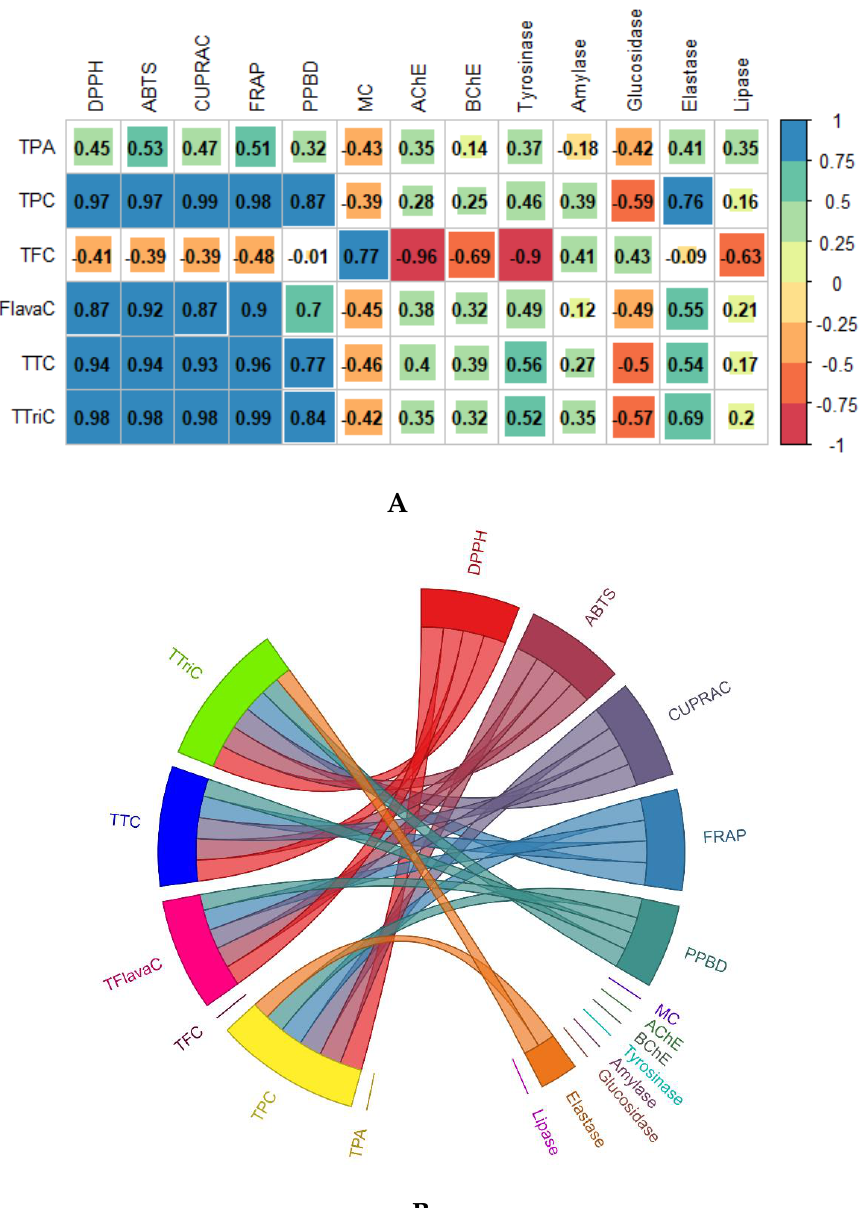
Figure 2. ( A ) Pearson correlation and ( B ) Chord diagram showing correlation between bio-compounds and biological activities. The connecting chord represents a Pearson’s correlation coefficient greater than 0.6.